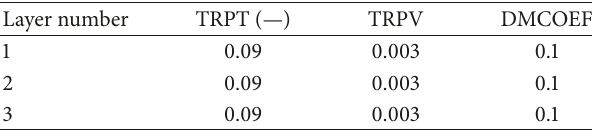
Table 4: Value of parameters for dispersive